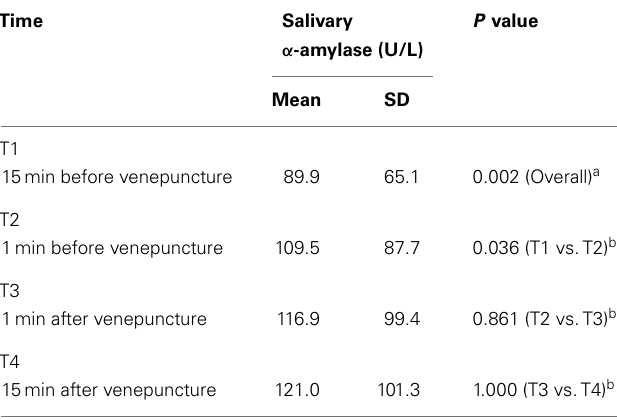
Table 1 | Change of salivary α -amylase (SAA) level at four-time measures of 58 workers before and after the venepuncture .